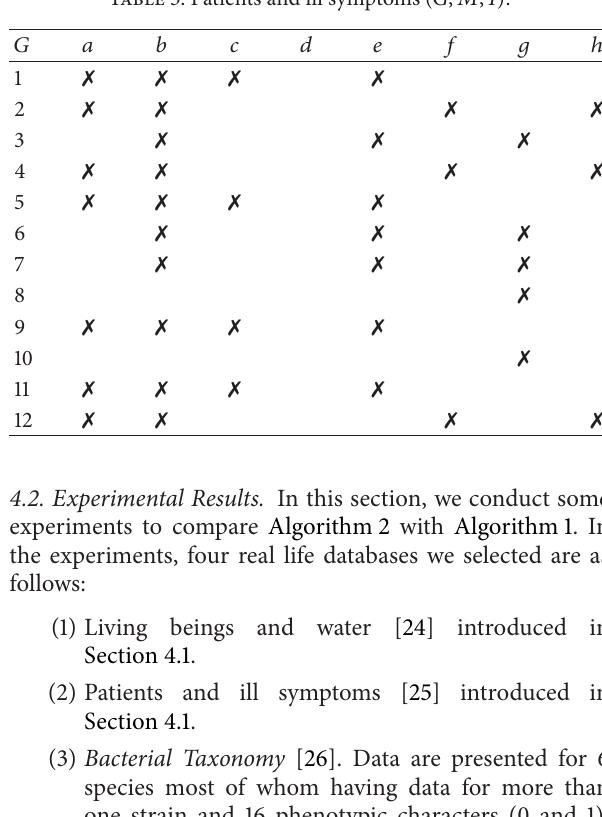
Table 3: Patients and ill symptoms (𝐺,𝑀, 𝐼) . Table 4: A contrast between